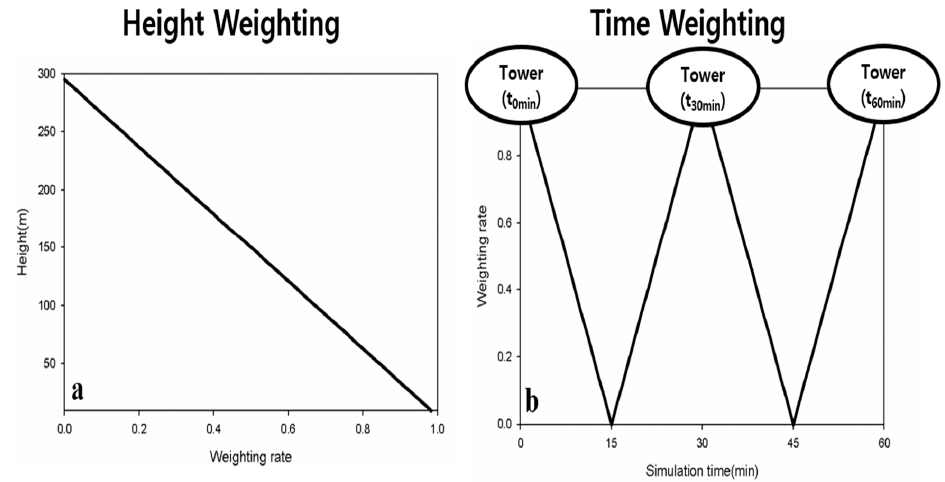
Figure 3. Weighting rates of height and time for the nudging. ( a ) Height Weighting; ( b ) Time